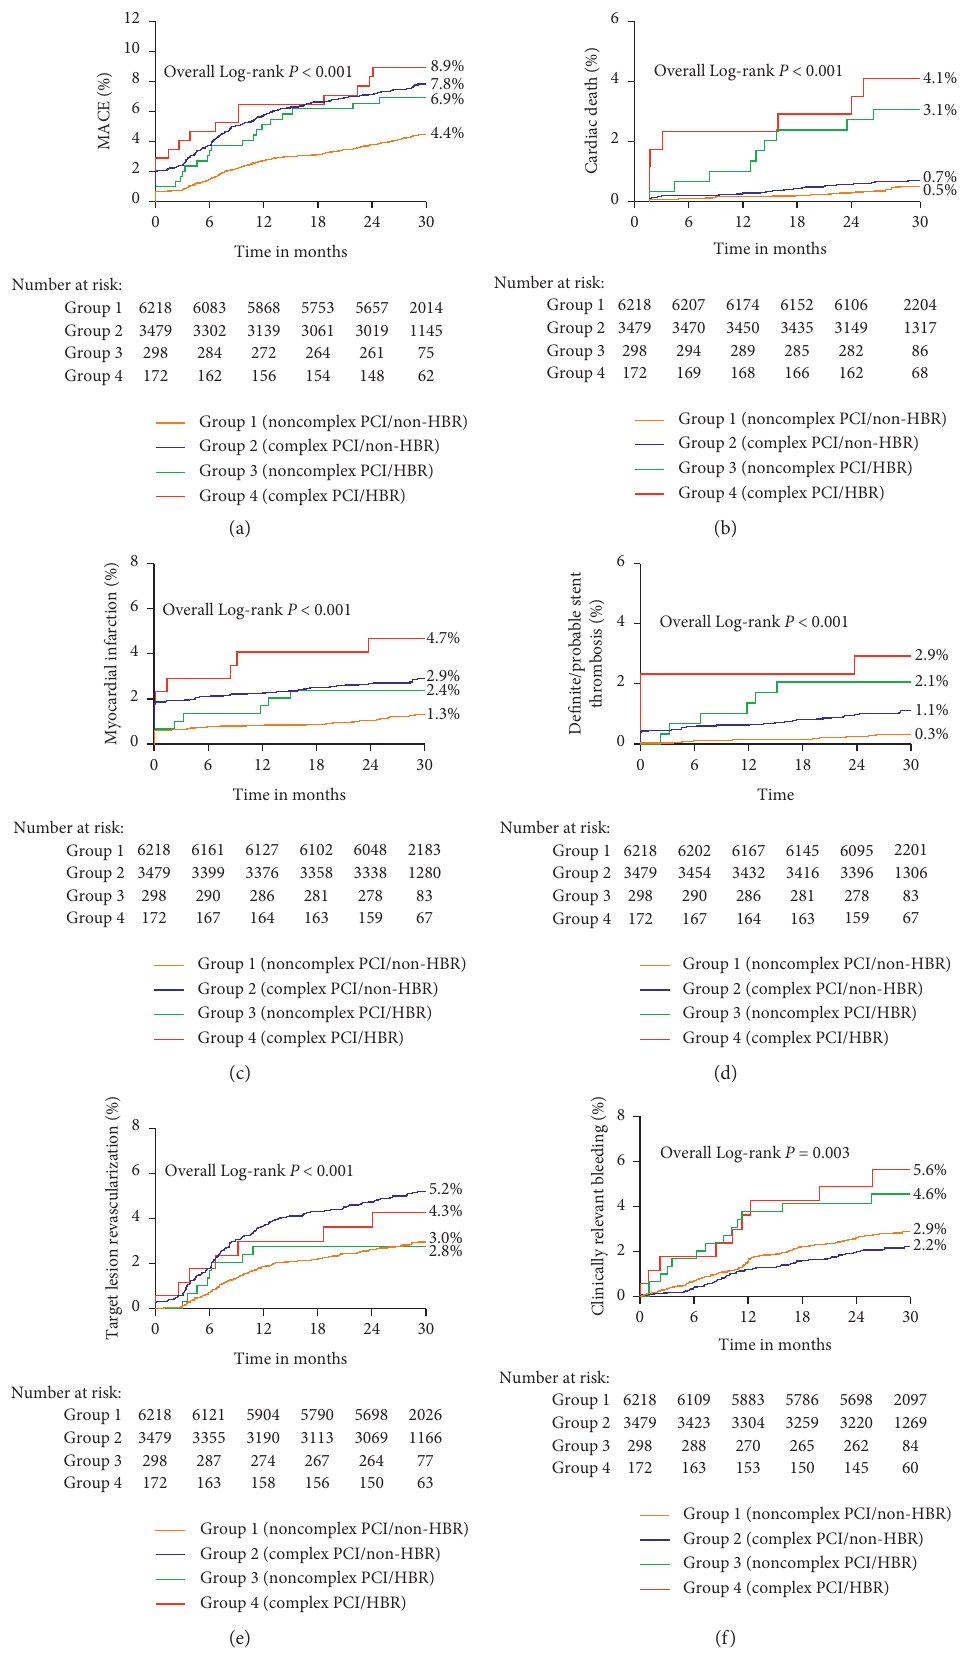
Figure 2: Kaplan–Meier cumulative event curves for (a) major adverse cardiovascular events (MACE), (b) cardiac death, (c) myocardial infarction (MI), (d) definite/probable stent thrombosis (ST), (e) target lesion revascularization (TLR), and (f) clinically relevant bleeding according to PCI complexity and HBR